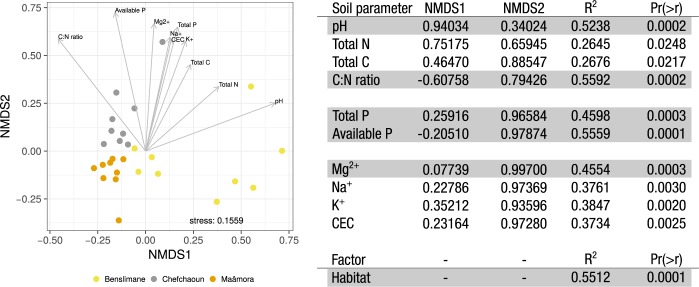
Nonmetric multidimensional scaling analysis of Q. suber root-associated fungal community structures (OTU level) in Moroccan cork oak habitats (Maâmora, Benslimane and Chefchaoun) and soil parameter fitting.The stress of the ordination is 0.1584. All significant soil parameters are shown by arrows (the length is proportional to the strength of the correlation. Factor fitting (Habitat) is indicated below the soil parameter. The most significant soil parameters and factor (P < 0.001) are indicated in bold in the table.